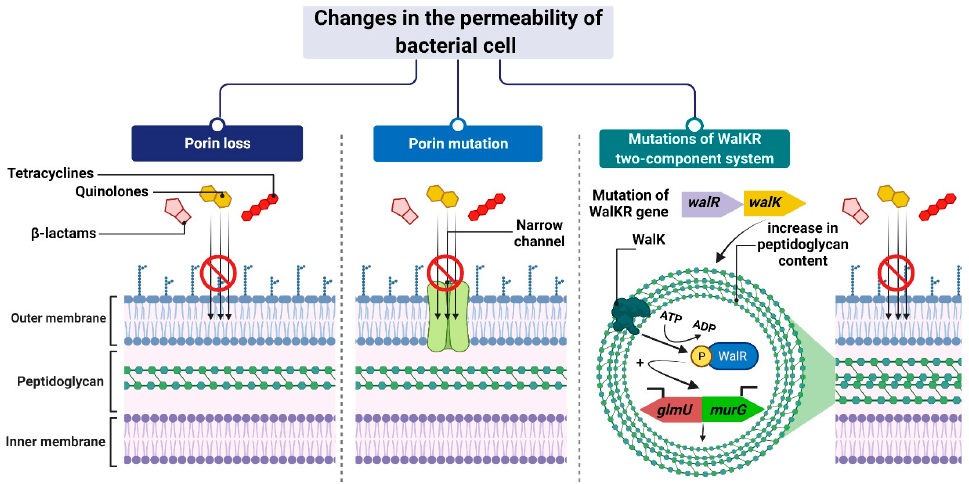
Figure 8. Reduced antibiotic accumulation through changes in the permeability of the bacterial cell. Figure created with Biorender.com.